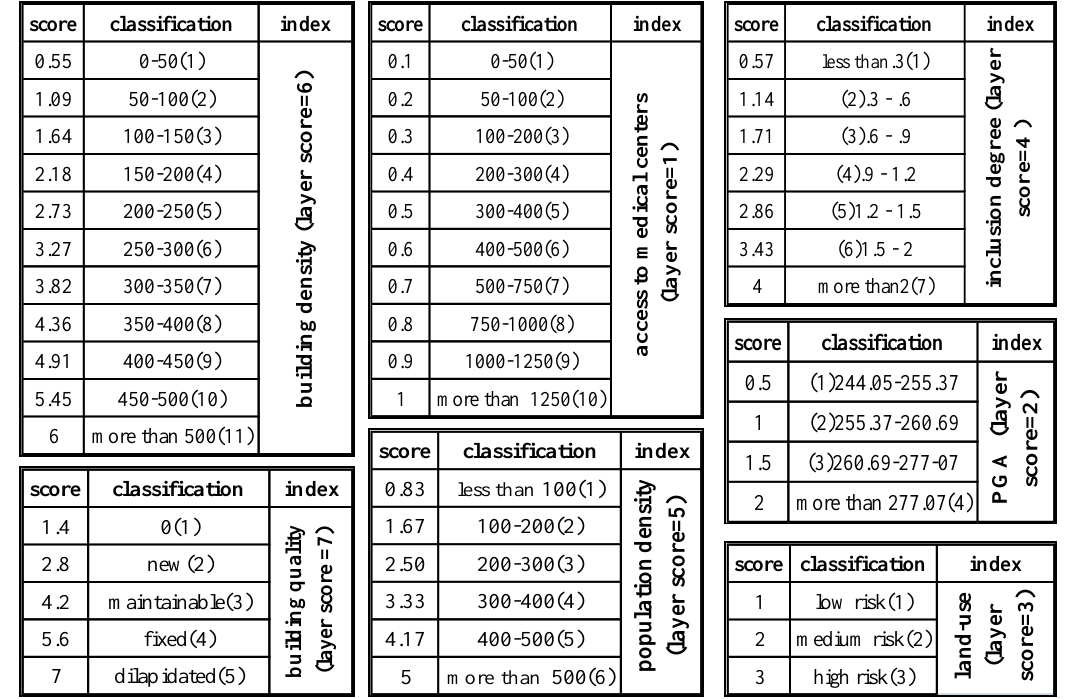
Table 2. Seven indexes, their classifications and calculating the score of each class using IHWP